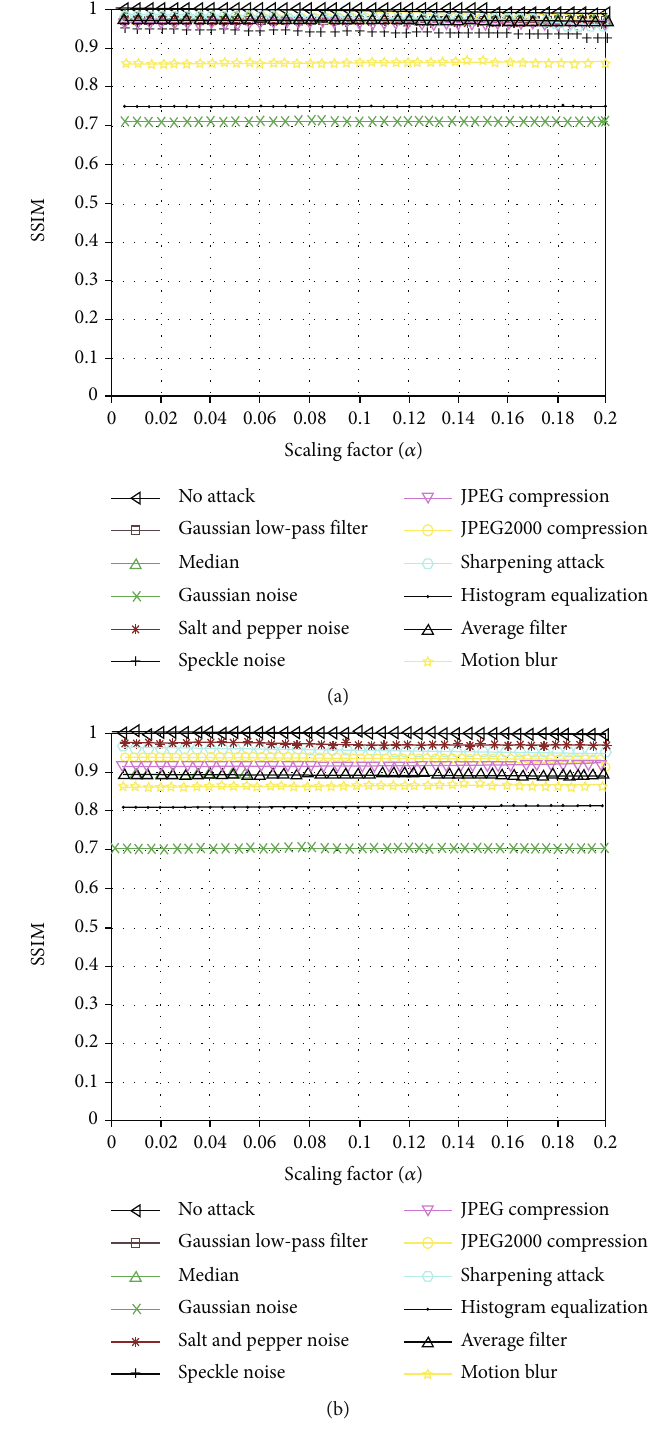
Figure 7: SSIM scaling factors: (a) lion image and b) Elaine